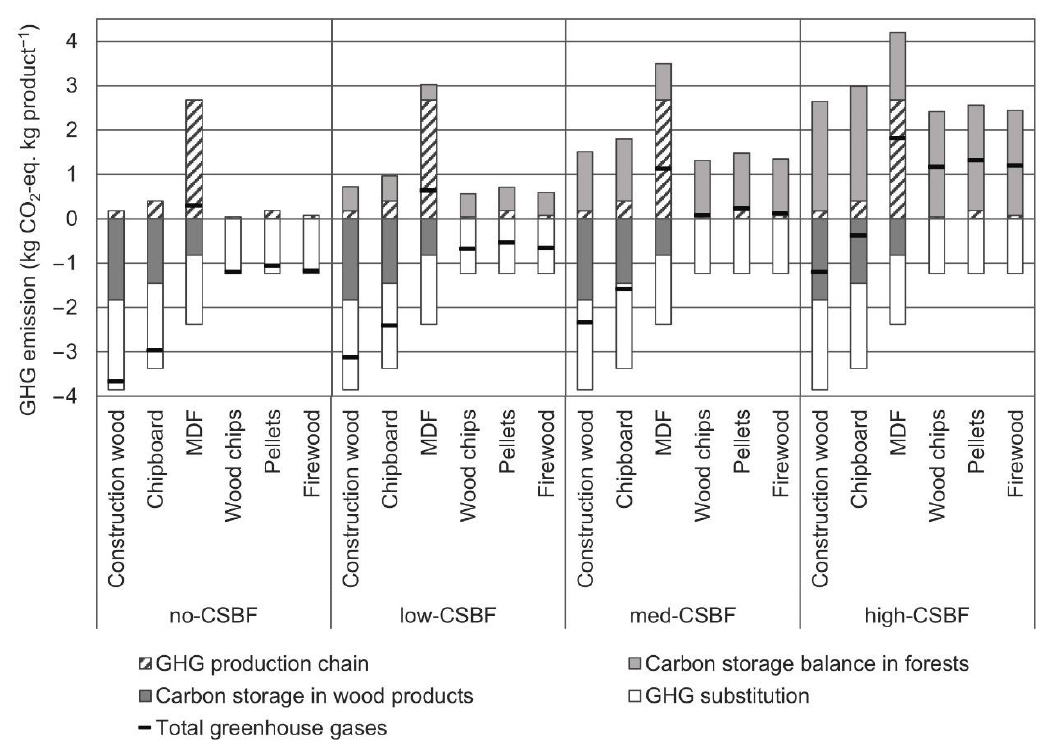
Figure 2. Total greenhouse gas balances of wood products (TBWP) in different carbon storage balance scenarios in forests. MDF = medium-density fiberboard, CSBF = carbon storage balance in forests. See explanation of the scenarios no-CSBF, low-CSBF, med-CSBF and high-CSBF in Table 3.